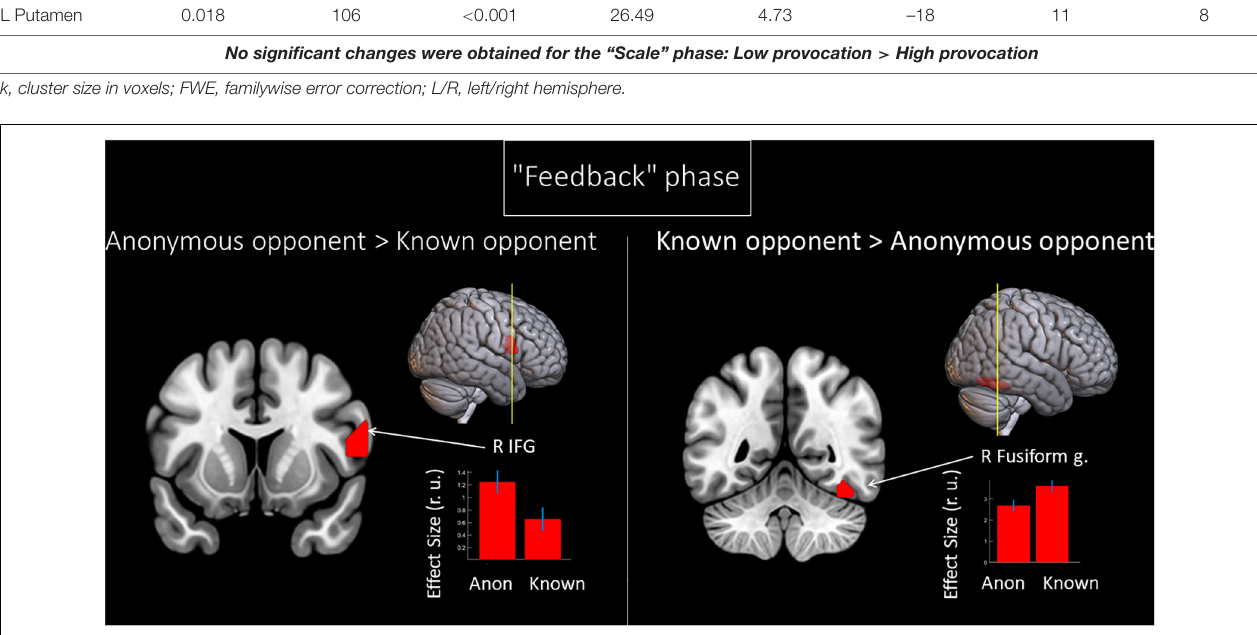
TABLE 2 | Results of the group-level analysis of the BOLD signal associated with selection of punishment (uncorrected p < 0.001 at the voxel level, FWE-corrected at the cluster level p < 0.05, and k = 15). Cluster Peak Peak MNI coordinates Brain area